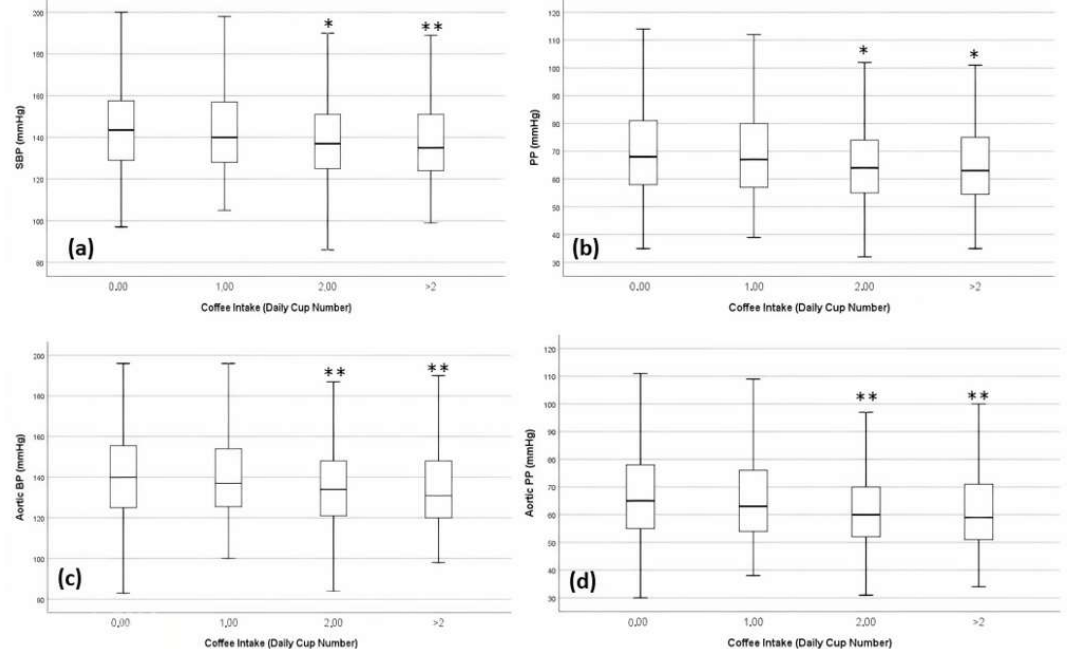
Figure 2. Distribution of ( a ) systolic blood pressure (SBP), ( b ) pulse pressure (PP), ( c ) aortic BP and ( d ) aortic PP in the BHS by coffee consumption (* p < 0.05 vs. no coffee intake, ** p < 0.05 vs. no coffee and 1 coffee cup